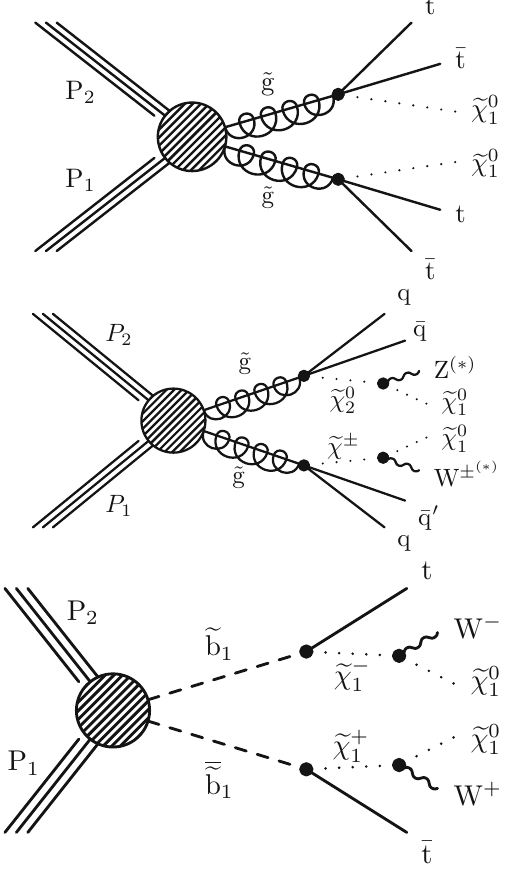
Fig. 1 Diagrams for gluino and bottom squark pair production leading to multilepton events for simplified models of supersymmetry: (top) T1tttt, (middle) T5qqqqWZ, and (bottom) T6ttWW